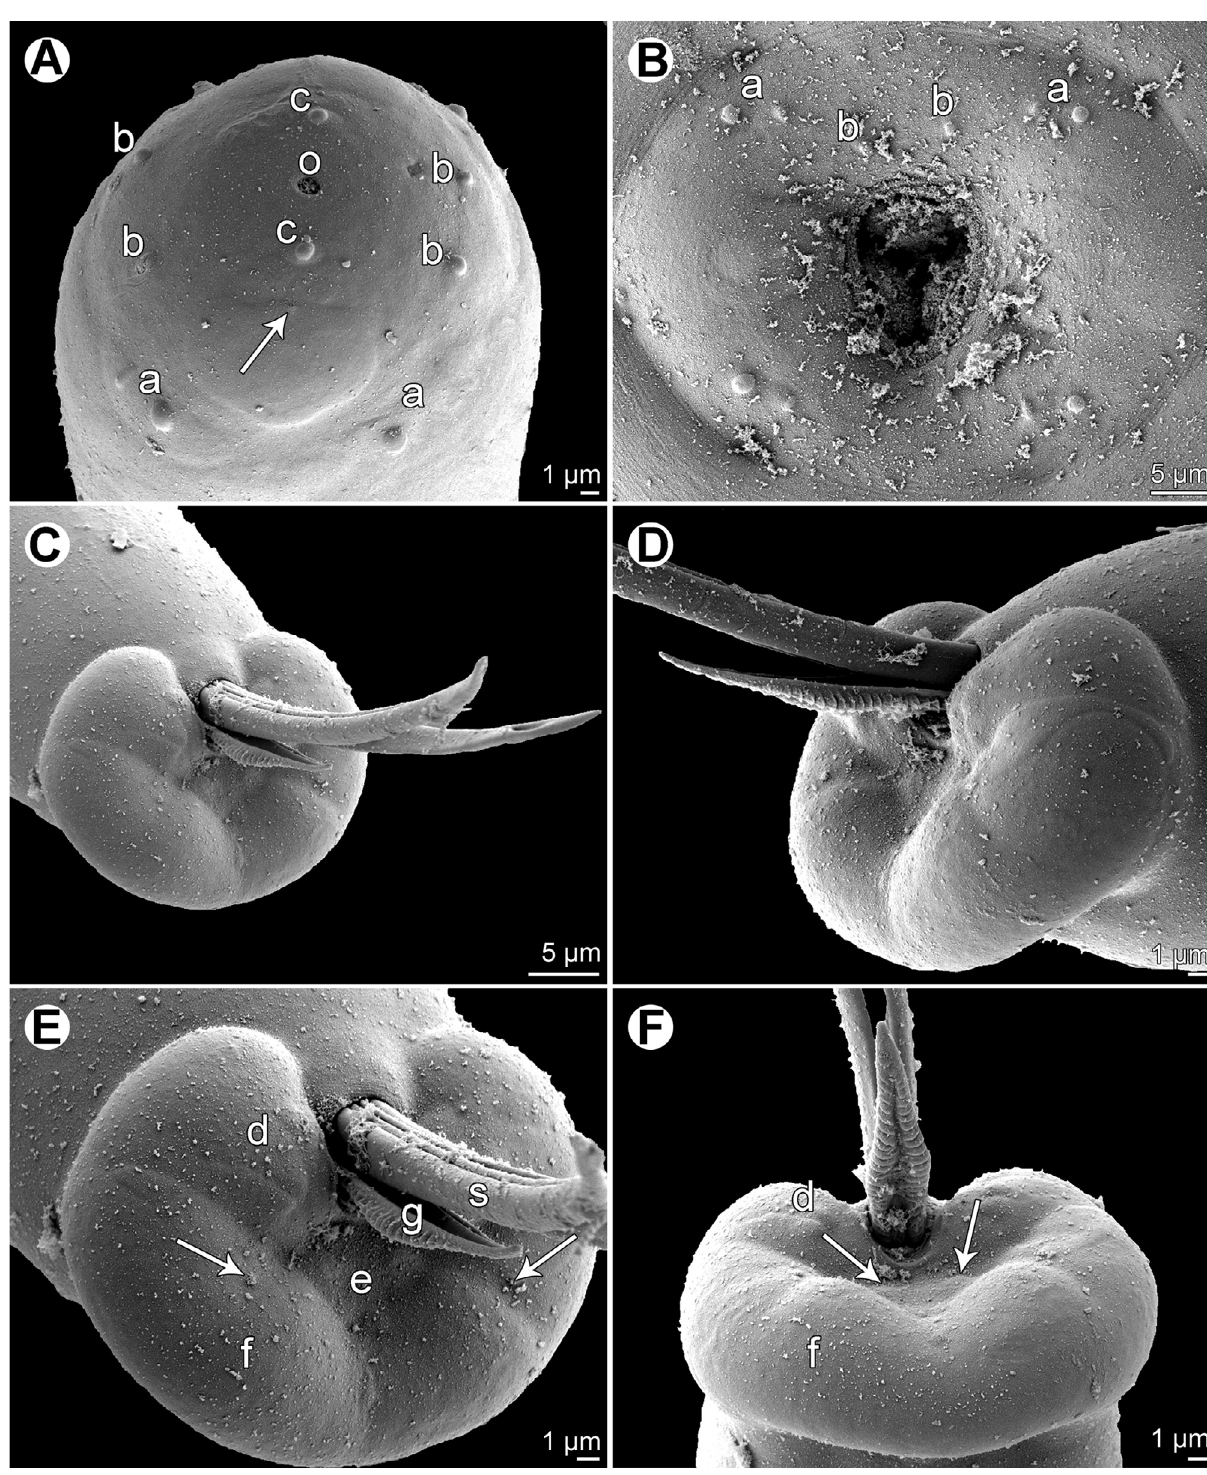
Figure 2. Philometra austropacifica n. sp. from Alepes vari , scanning electron micrographs. A: Cephalic end of male, subapical view (arrow indicates amphid). B: Cephalic end of subgravid female, apical view. C: Caudal end of male, subapical view (note aperture near distal tip of one spicule). D: Same, sublateral view (another specimen). E: Caudal end of male, subapical view (enlarged; arrows indicate phasmids). F: Same, dorsal view (arrows indicate papillae situated posterior to cloacal aperture). Abbreviations : a, submedian pair of cephalic papillae of external circle; b, submedian cephalic papilla of internal circle; c, lateral cephalic papilla of internal circle; d, group of four caudal papillae near cloacal aperture; e, pair of papillae situated posterior to cloacal aperture; f, caudal mound; g, gubernaculum; o, oral aperture; s,